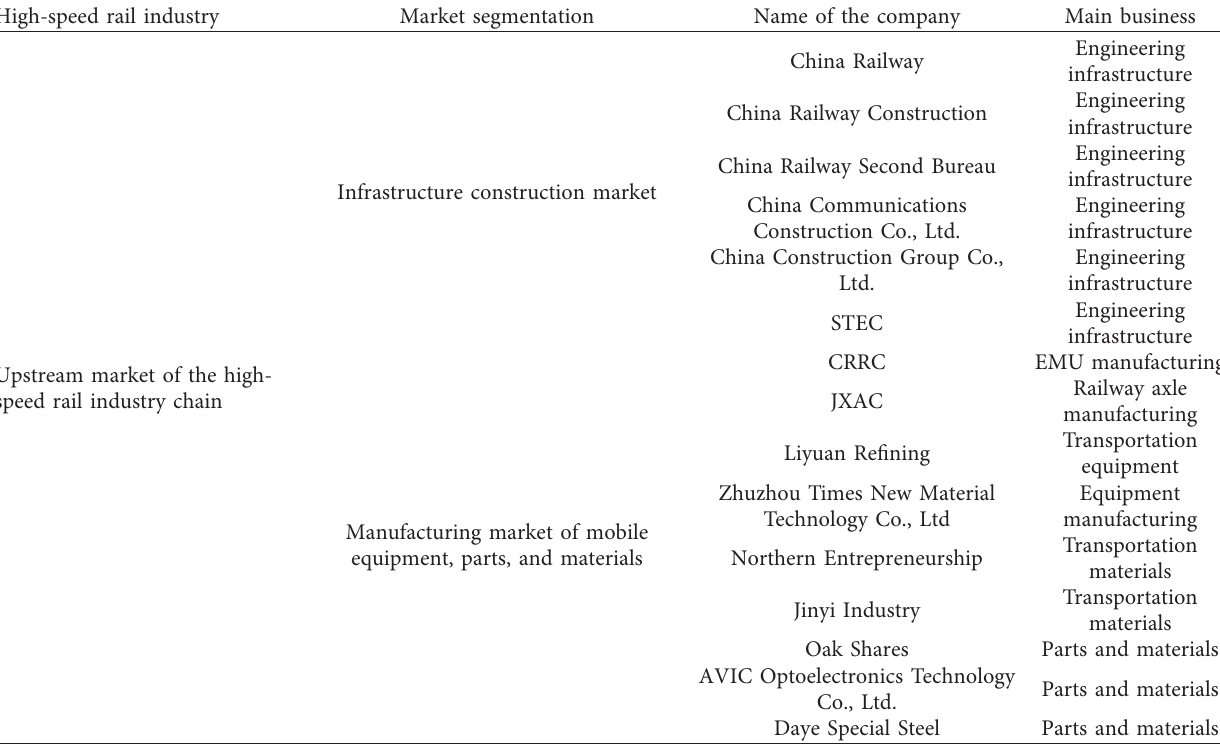
Table 1: Main listed companies in the upstream market of high-speed rail industry.